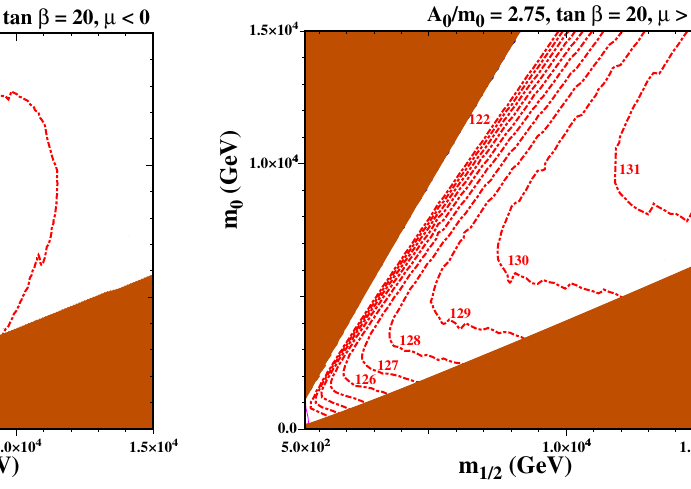
though they are still essentially invisible). The endpoint of the strip in the left panel is marked with an X, but is beyond the range of the right panel. Regions where the LSP is charged are shaded brick red and contours of M h are indicated by red dot-dashed lines